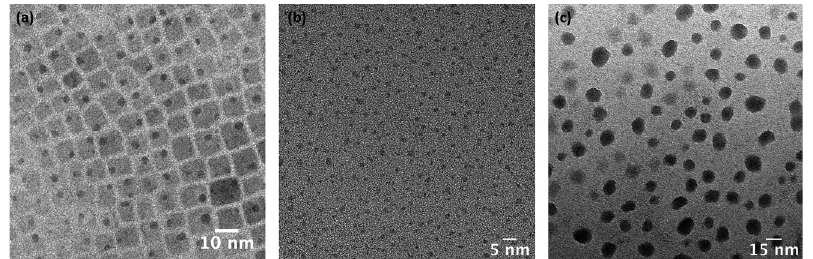
Figure 1: Transmission electron microscopy (TEM)imagesofassynthesizedCsPbX 3 QDs in this